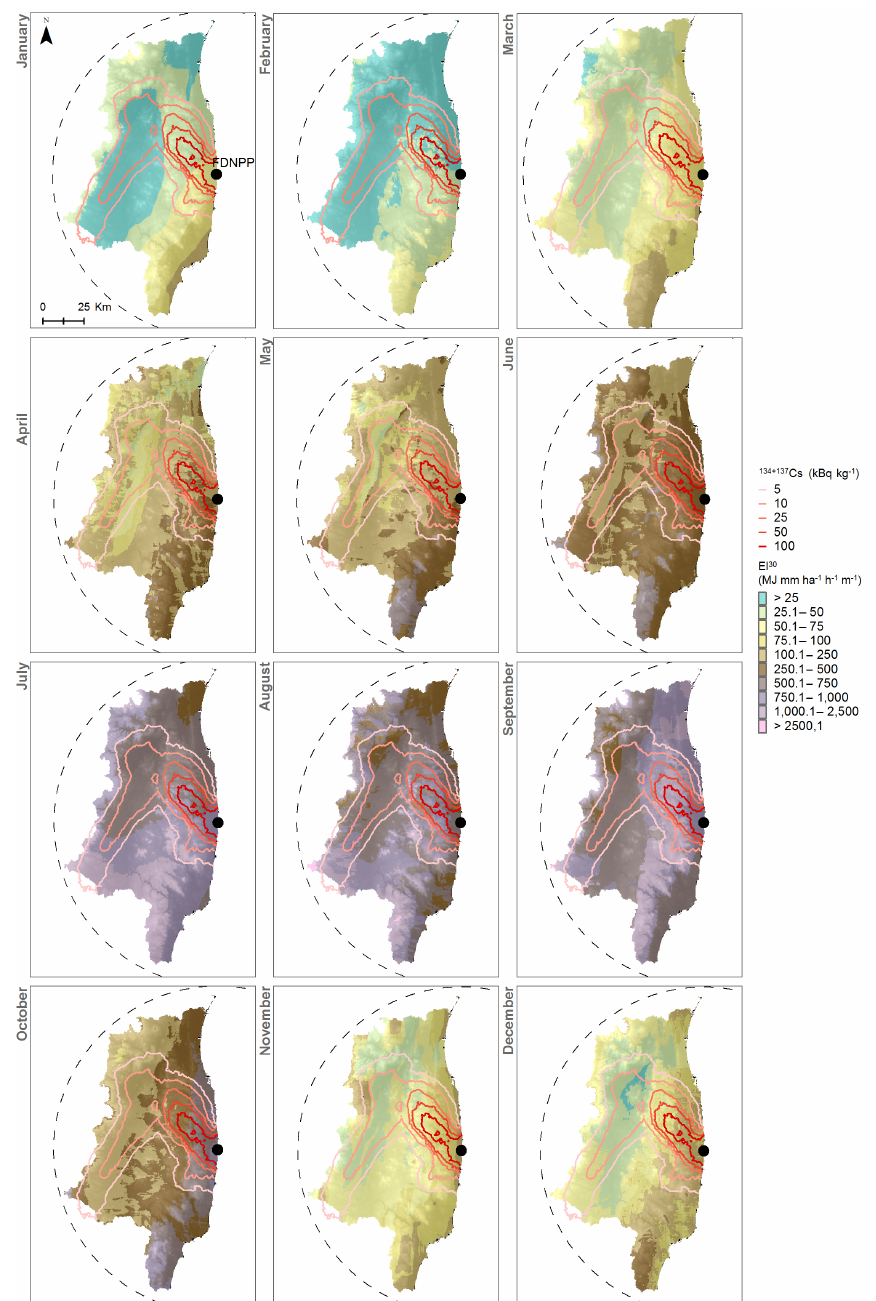
Figure 8. Monthly R factor distribution for catchments contained entirely within a 100km radius of the FDNPP. 134 + 137 Cs activities are from Chartin et al.